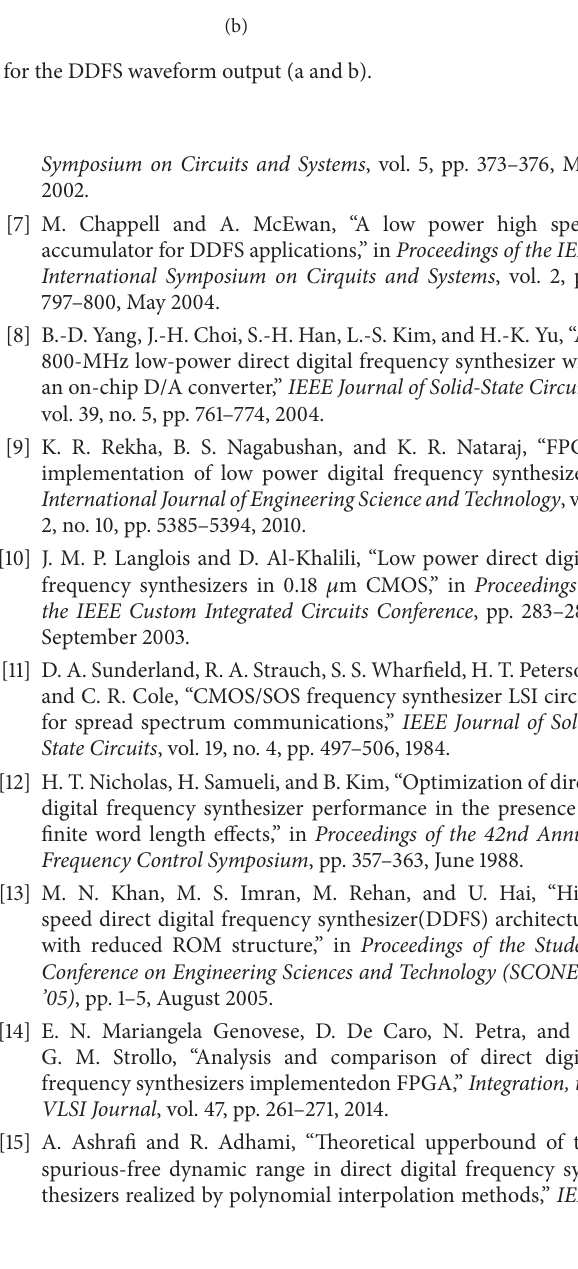
Figure 10: The measured signal-to-noise ratio for the DDFS waveform output (a and b).